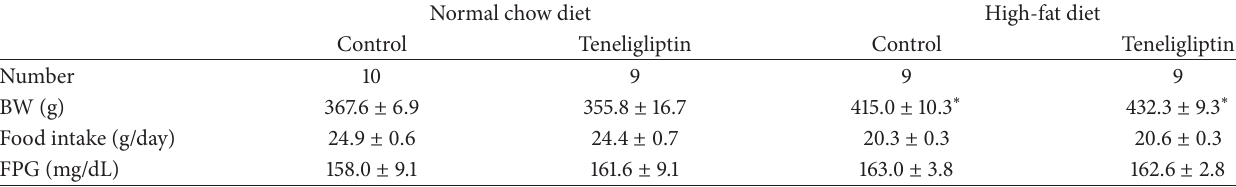
Table 2: Body weight, food intake, and fasting plasma glucose measurements in NCD-fed and HFD-fed rats. Normal chow diet